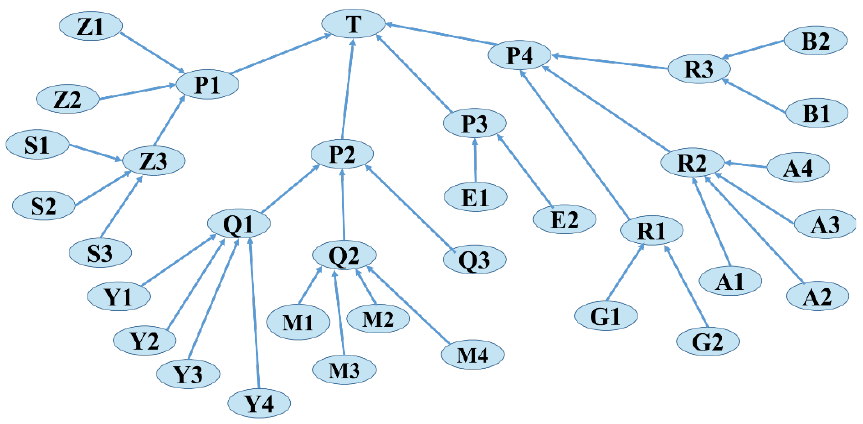
Figure 7. Model of BNs for disconnect operations.